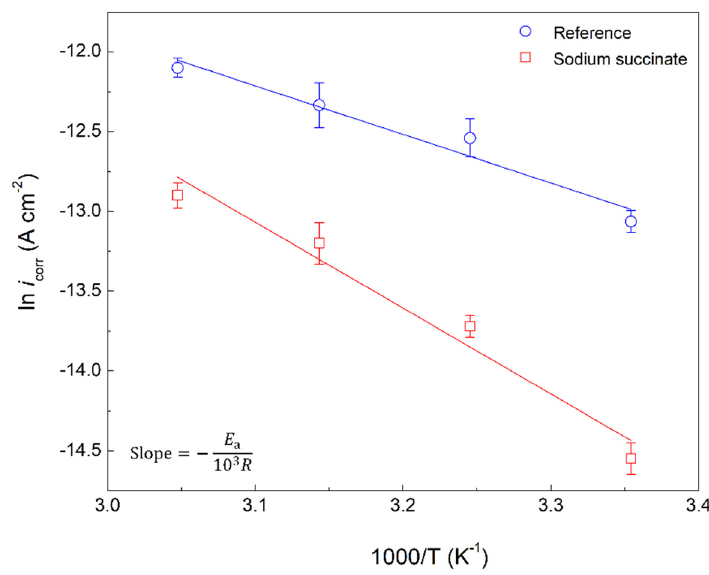
Figure 8. Arrhenius plot of carbon steel rebars in the presence and absence of 0.6 M sodium succinate in 0.6 M Cl − SCPS. Table 4. Activation parameters of carbon steel in the absence and presence of 0.6 M sodium succinate in 0.6 M Cl −